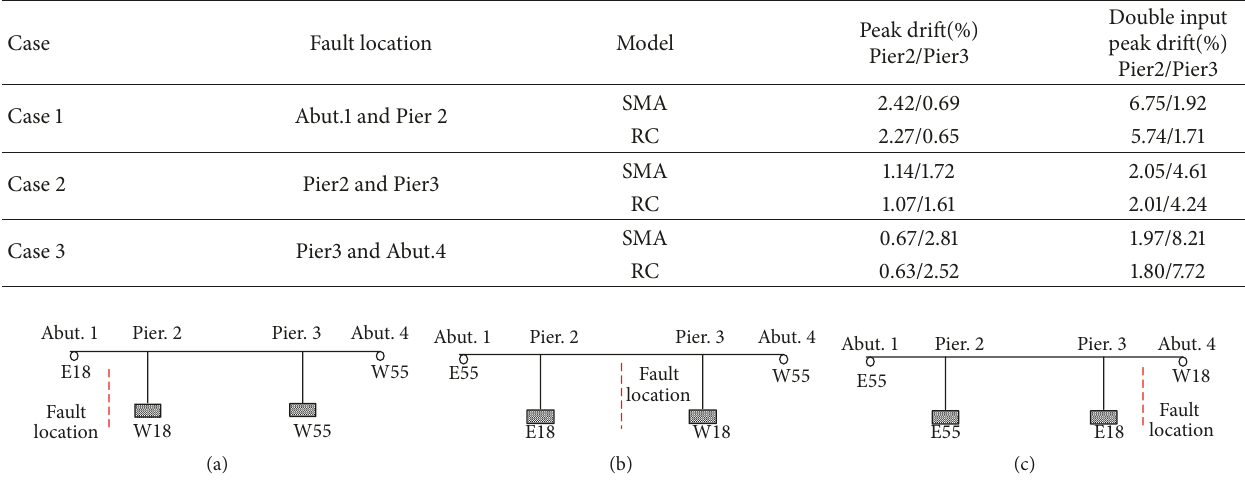
Figure 11: Different cases for fault location: (a) Case 1, (b) Case 2, and (c) Case